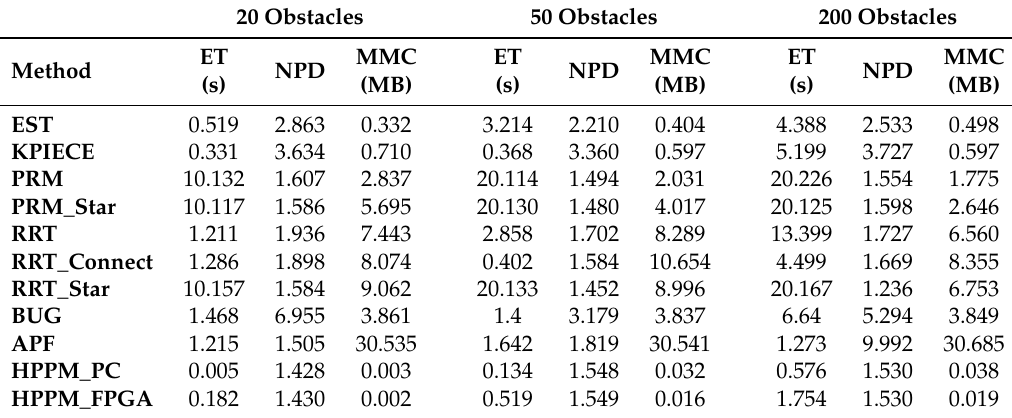
Table 4. Comparative median results of Execution Time (ET), Normalized Path Length (NPD), and Median Memory Consumption